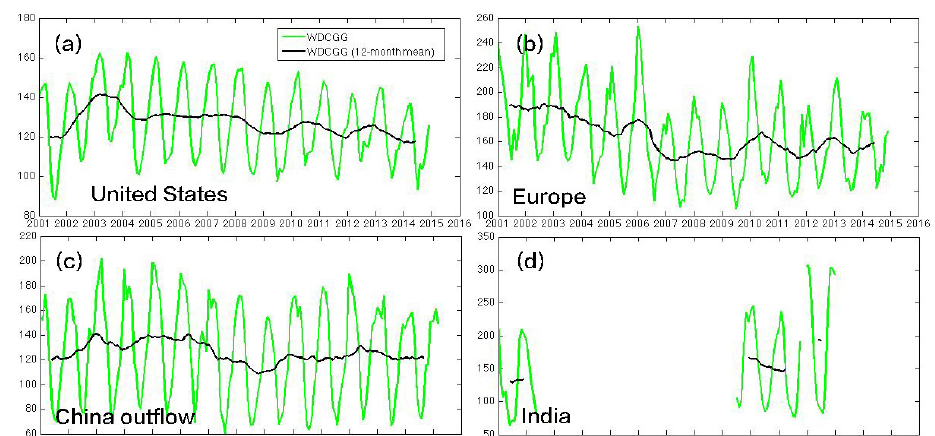
Figure 7. Monthly mean CO concentrations (green) and 12-month mean value (black) from WDCGG stations for 2001–2015. (a) 15-station average in the United States; (b) 20-station average in Europe; (c) 2-station (YON and Minamitorishima (MNM)) average in east China outflow; (d) Cape Rama (CRI) in